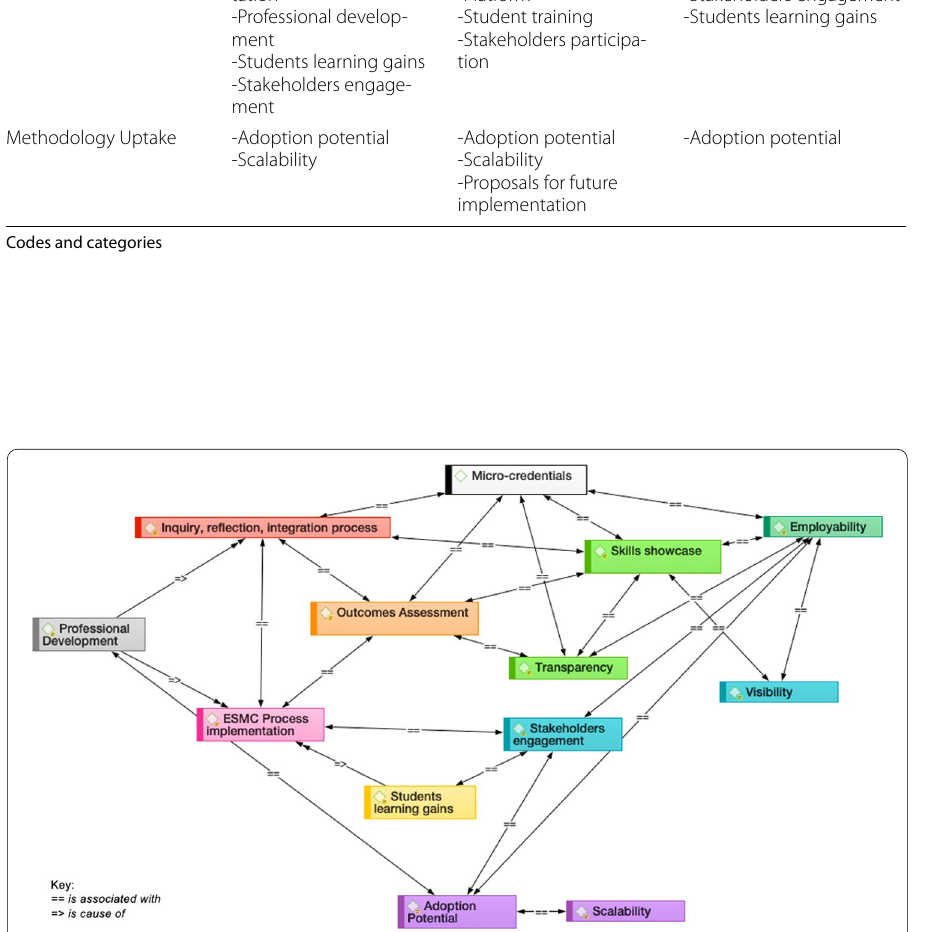
Fig. 6 Network of the semantic linkages between the codes emerging from the lecturer